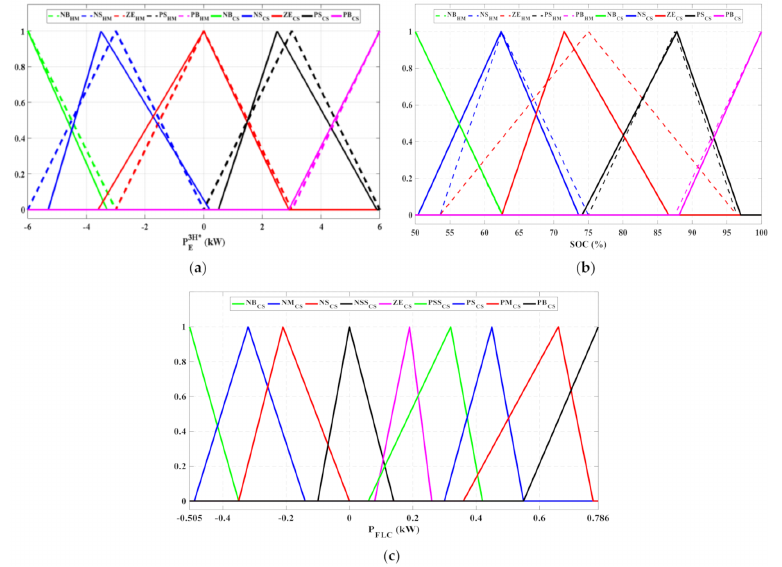
Figure 5. Resulting MFs through Cuckoo search (CS) algorithm ( a ) input P 3 H ∗ ( c ) output P FLC